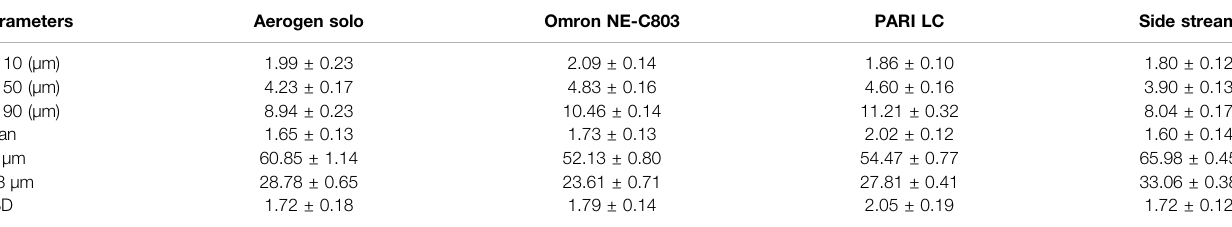
TABLE 2 | A comparative account on performance characteristics of different nebulizers. Data expressed as mean ± SD ( n (cid:2) 3).